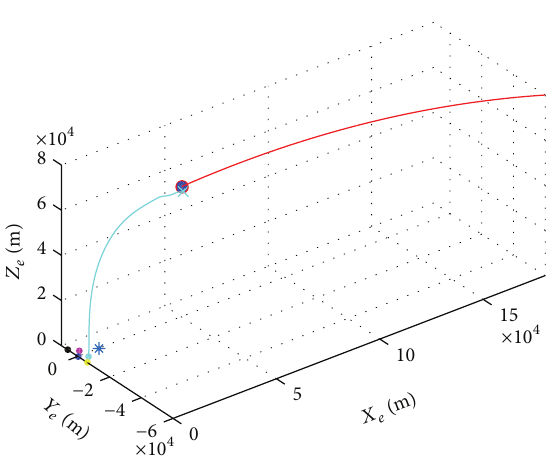
Figure 7: Interception of a high altitude-low velocity ballistic target. Red line depicts the trajectory of the ballistic target. Algorithm chooses only 1 missile for